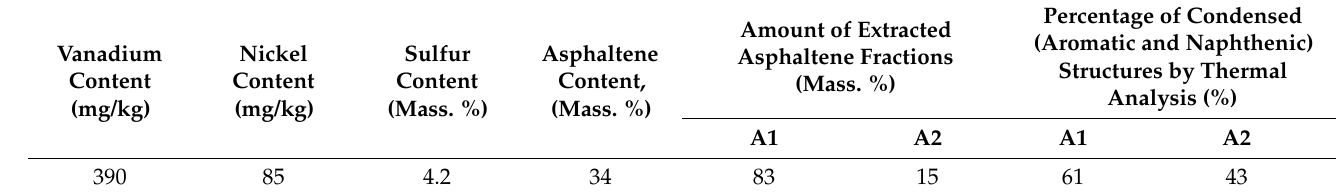
Table 1. Content of V, Ni, S [48], and asphaltenes fractions in the sample of the oxidized bitumen. Percentage of Condensed (Aromatic and Asphaltene Fractions